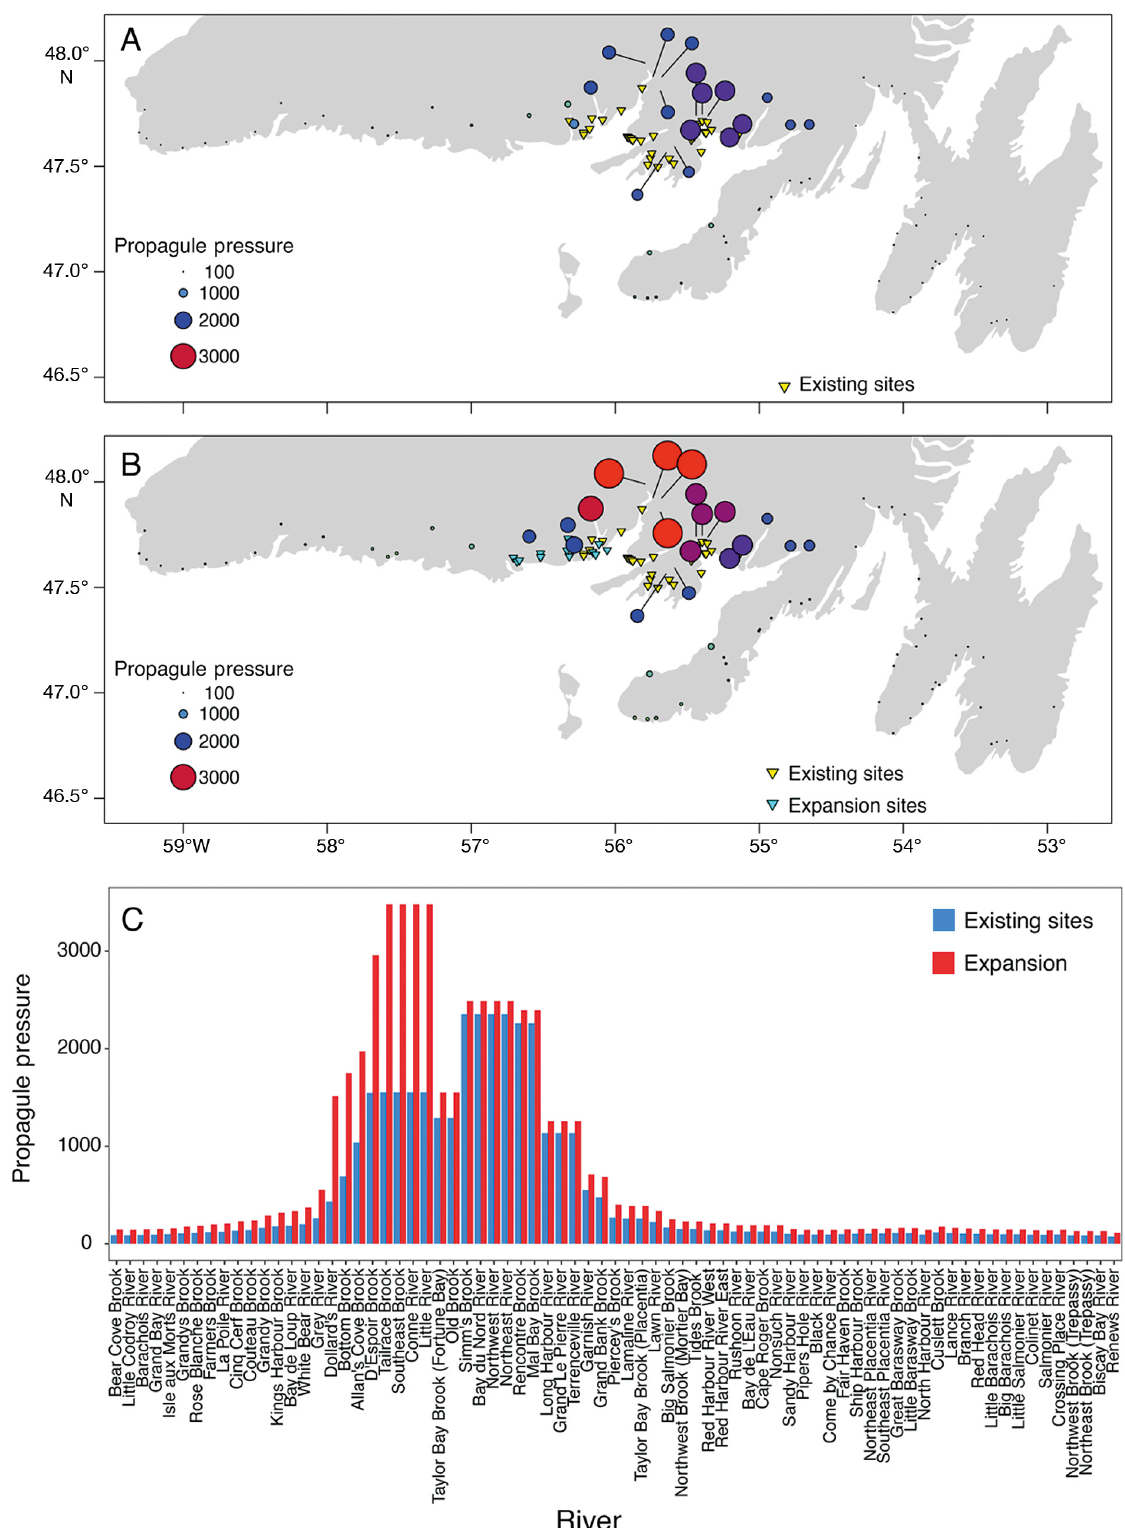
Fig.5.PropagulepressurecalculatedfollowingKeyseretal.(2018)forsouthernNewfoundlandunder(A,C)theexistingproduction regime and (B,C) the proposed expansion scenario. See Section 2 for details. (C) Rivers are arranged west to east along the x